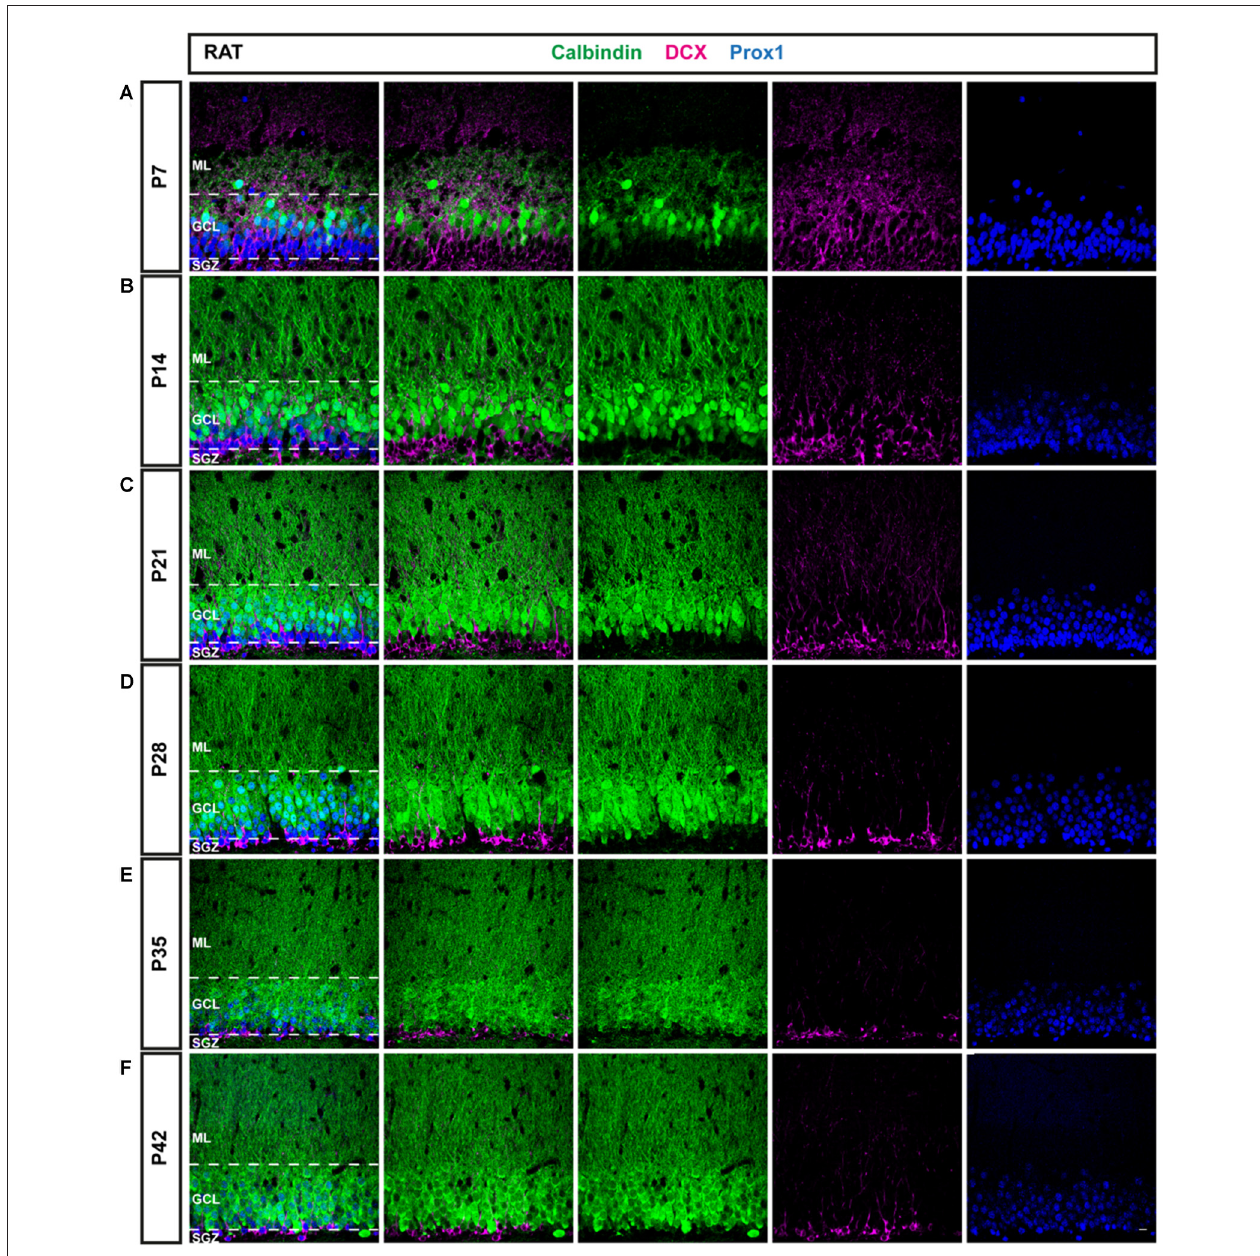
FIGURE 2 | Immunohistochemical illustration of CB, DCX, and Prox1 distribution in the postnatal DG of the rat. (A–F) Immunostainings of the postnatal rat DG from P7 to P42 show increasing maturation, similarly as in the mouse. However, a larger proportion of GCs expressed CB (green) at early time points and the fraction of DCX-positive cells (magenta) decreased more rapidly than in the mouse, especially between P7 and P14. Prox1 (blue) was expressed in both mature and immature GCs at all time points. Scale bar: 10 µ